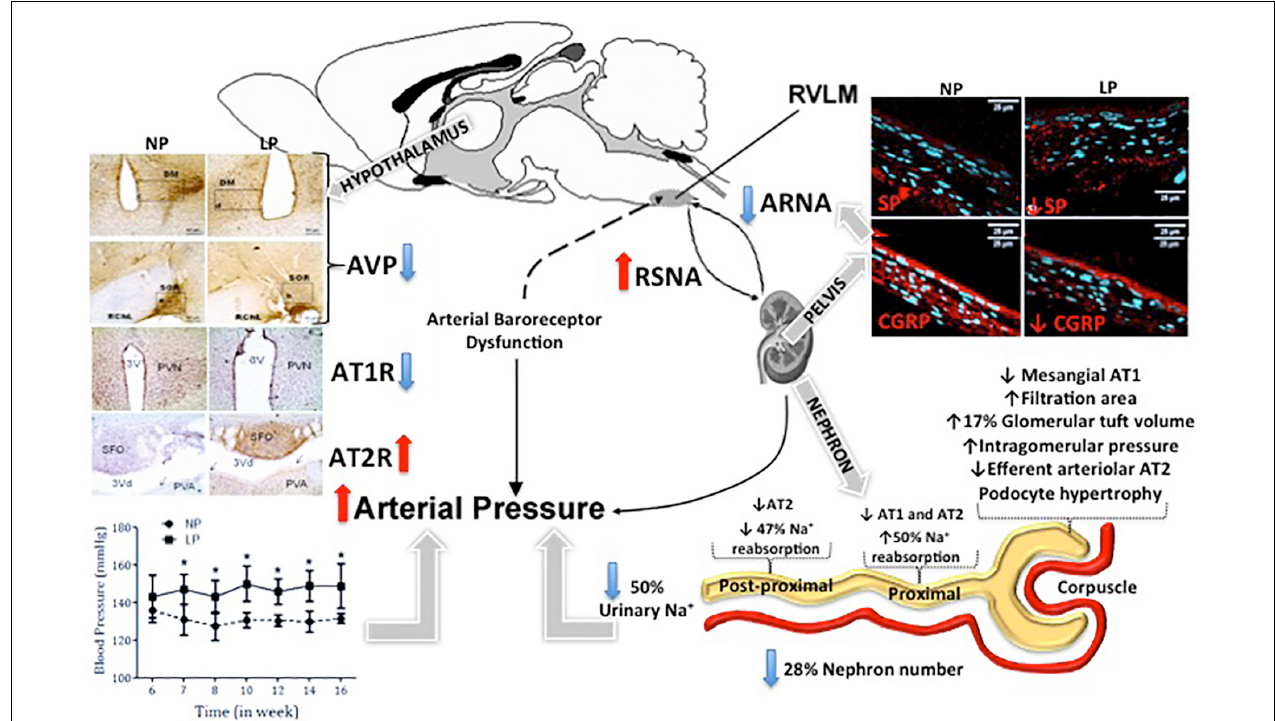
FIGURE 1 | Schematic diagram of fetal programming and arterial hypertension development. The figure depicted that blunted natriuretic effect observed in low-protein intake (LP) offspring. This phenomenon may, at least in part, be due to the reduced number of nephrons associated with renorenal reflex impairment, which promoted increased renal nerve sympathetic activity, finally causing arterial pressure enhancement. This kidney neural reflex disorder may respond to the significant substance P (SP) and calcitonin-gene related peptide (CGRP) content changes of the dorsal root ganglia (DRG) in this model, which potentially participates in a deregulated afferent physiological phenomenon. Rostral ventrolateral medulla (RVLM); Renal sympathetic nerve activity (RSNA); Arginine vasopressin (AVP); Afferent renal nerve activity (ARNA); Type-1 angiotensin (AT1R) and type-2 angiotensin receptors (AT2R); Maternal normoprotein intake group (NP); Maternal hypoprotein intake group. * p <